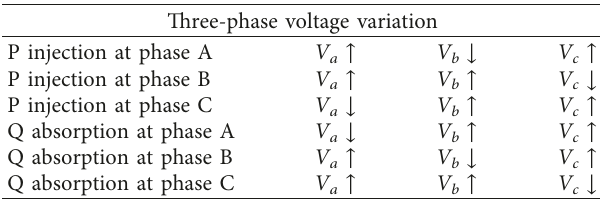
Figure 5: Three-phase voltage sensitivity with respect to single-phase power flow: (a) only active power injection at Phase C; (b) only reactive power absorption from Phase C. Table 3: Summary of three-phase voltage